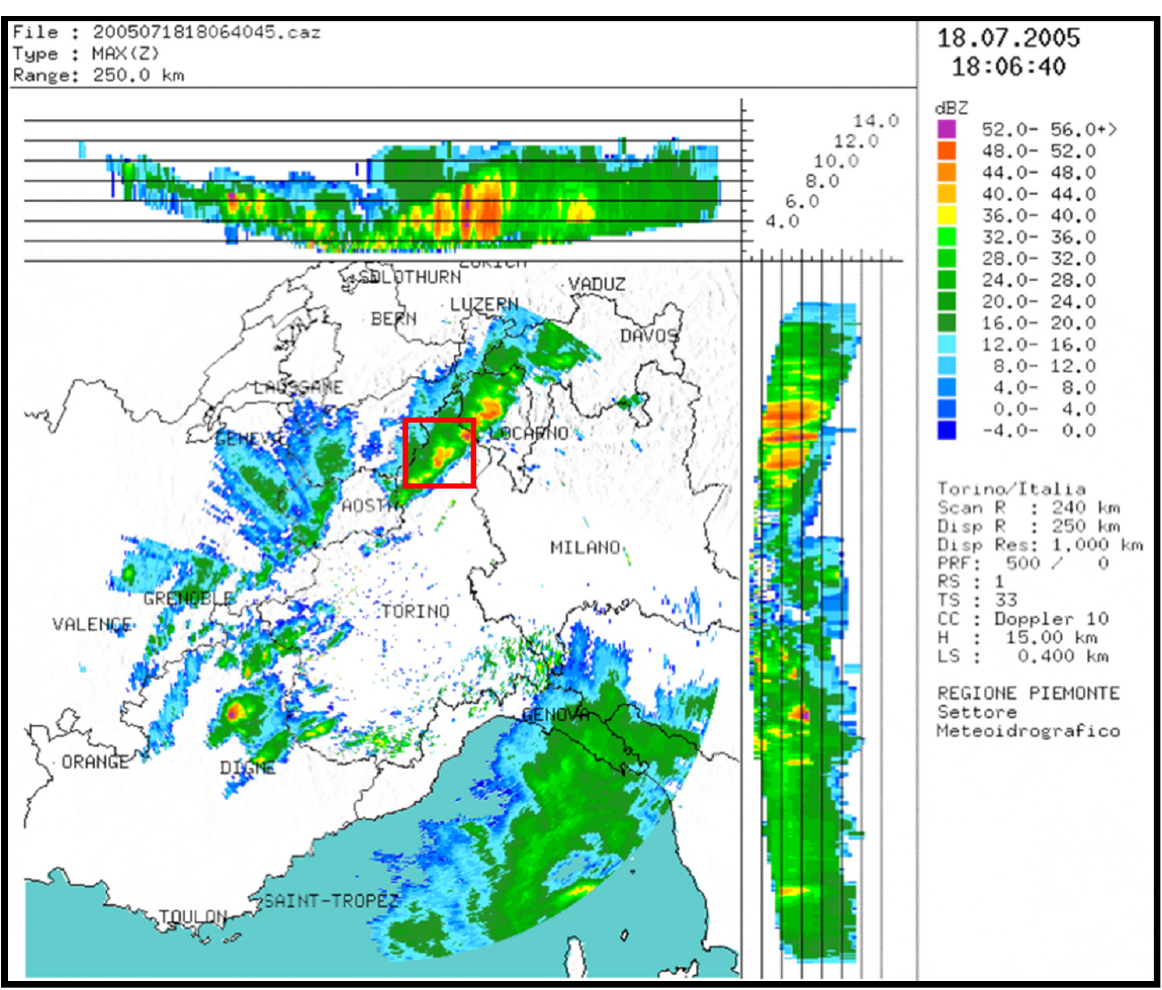
Figure 14. Rainfall field distribution map (map representation from old weather radar systems) estimated by the weather radars on 18 July 2005. Red square indicates the Rio Casella catchment location. Weather radar estimates a cumulated daily rainfall value of 35.4 mm corresponding to 48 dBZ.